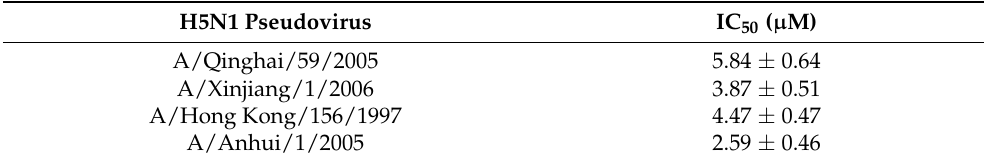
Table 3. Inhibitory activities of nisoldipine against different H5N1 pseudoviruses infection (mean ± SD, n =